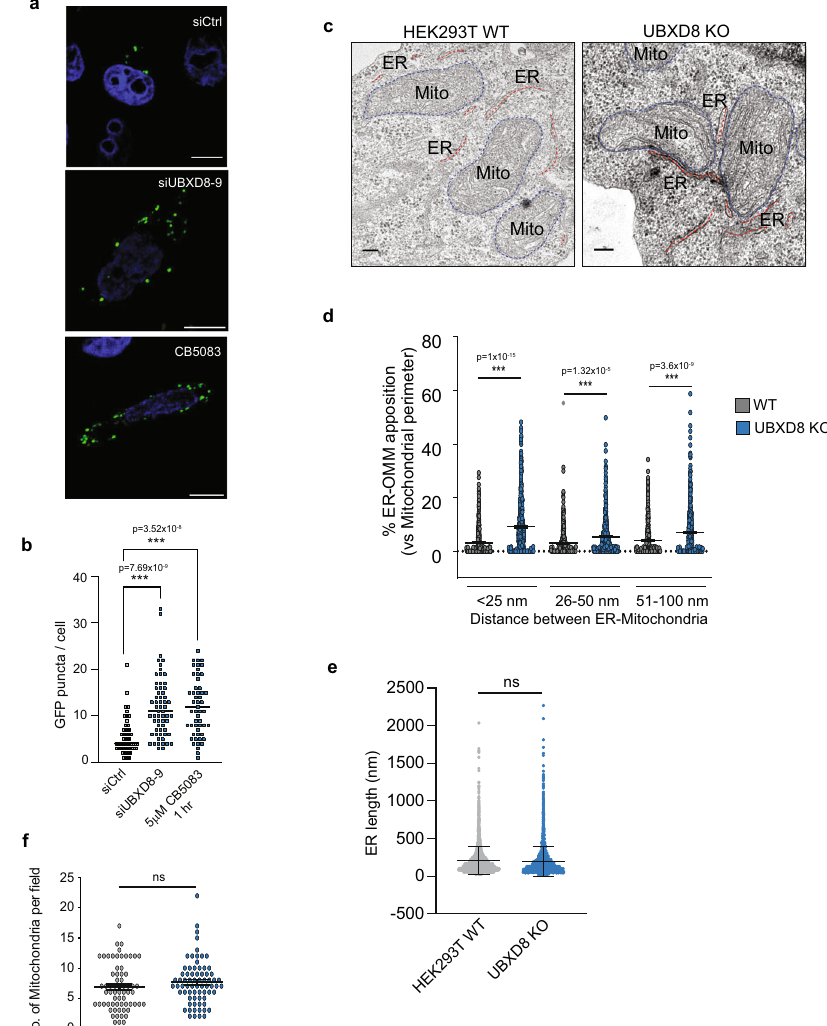
Fig. 3 | UBXD8 knock out or p97 inhibition results in increased ERMCS. a Representative microscopy images showing ERMCS as depicted by formation of fl uorescent GFP puncta at ERMCS by split-GFP-based contact site sensor (SPLICS) system comprising OMM-GFP 1-11 and ER-short-GFP β 11 ) 27 . Scale bar, 10 μ m. b Quanti fi cationofGFPpunctapercellasaproxyforERMCSuponsiRNA-mediated repression of UBXD8 or p97 inhibition by small molecule inhibitor, CB5083 (5 μ M, 1h). (Cell numbers used for quanti fi cation: siControl=57 cells; siUBXD8#9=61 cells; CB5083=52 cells, across n =3 biologically independent samples). c Representative TEM micrographs of wildtype and UBXD8 KO HEK293Tcells illustratingcontactsbetween ER (reddotted line)and mitochondria